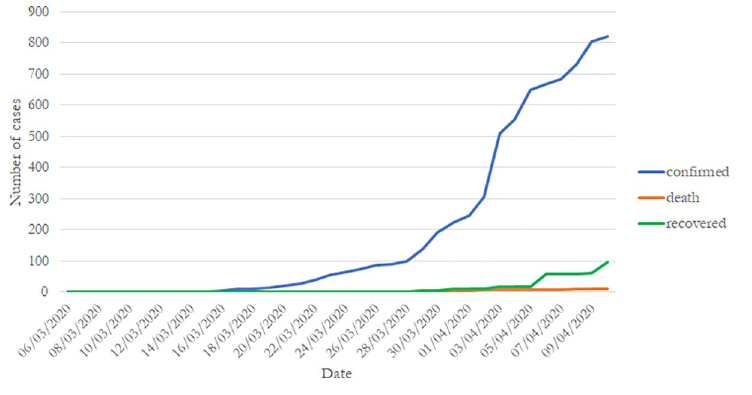
Fig 1. Number of observed cases of COVID-19 in